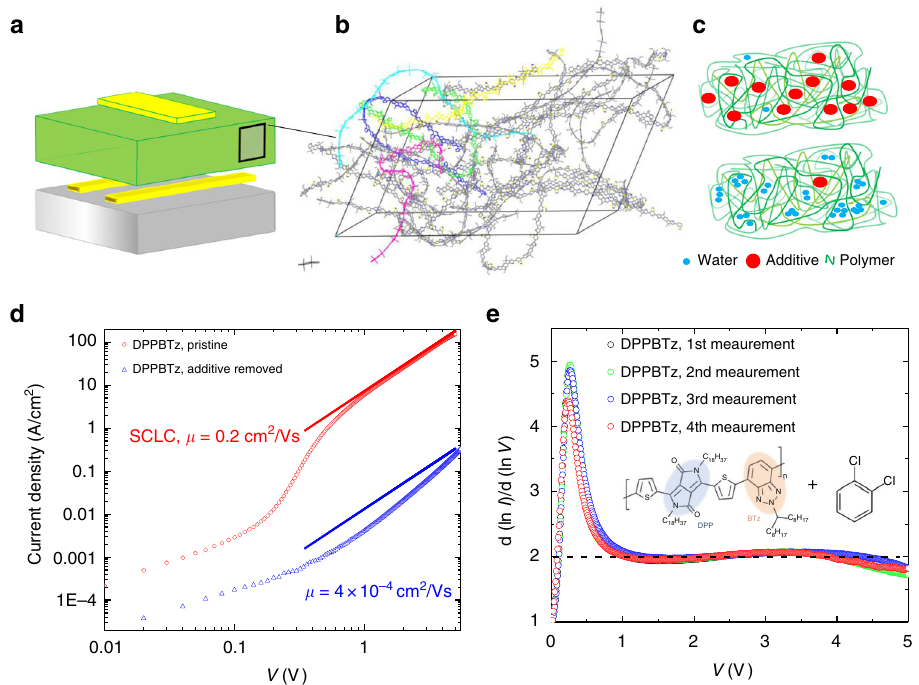
Fig. 1 Space charge-limited conduction (SCLC) characteristics of poly[[2,5-bis(2-octadecyl)-2,3,5,6-tetrahydro- − 3,6-diketopyrrolo[3,4- c ]pyrrole-1,4-diyl]- alt-(2-octylnonyl)-2,1,3-benzotriazole] (DPP-BTz) diodes with and without additives. a Device structure of SCLC polymer diodes used (dimensions of crossbar overlap A = 20 × 200 µ m 2 ); b simulated structure of a high-mobility amorphous polymer (adapted from ref. 11 ); c passivation of water-induced traps in the polymer ’ s microstructure through the use of additives (red). Removal of additives allows water molecules (blue) to interact with polarons on the polymer backbone and disturb charge transport; d hole-only SCLC diode characteristics for the polymer DPP-BTz (thickness 220 nm). Using a solvent additive, record, fi eld-independent SCLC mobilities of 0.2 cm 2 /Vs are reached. After solvent removal, performance drops by a factor of ~500 and trap-free SCLC behavior vanishes. e Power law exponent m ¼ ∂ Ln ð I Þ ∂ of the SCLC characteristics extracted during repeated measurements with excellent Ln ð V Þ reproducibility. The chemical structure of DPP-BTz as well as the additive (residual 1,2-dichlorobenzene (DCB) solvent) is also (indicated by the blue solid line). In the absence of a molecular additive (residual solvent DCB), the transport remains trap lim-